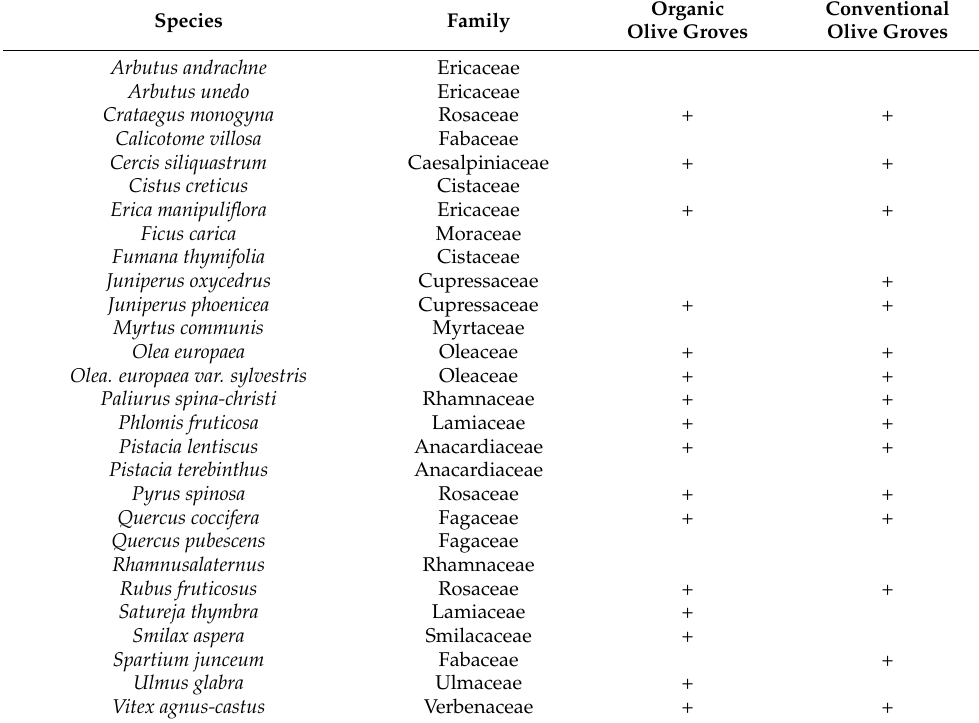
Table A3. Woody plant species recorded in organic and conventional olive groves. Species nomencla- ture according to Dimopoulos et al. (2013, 2016) [37,38].